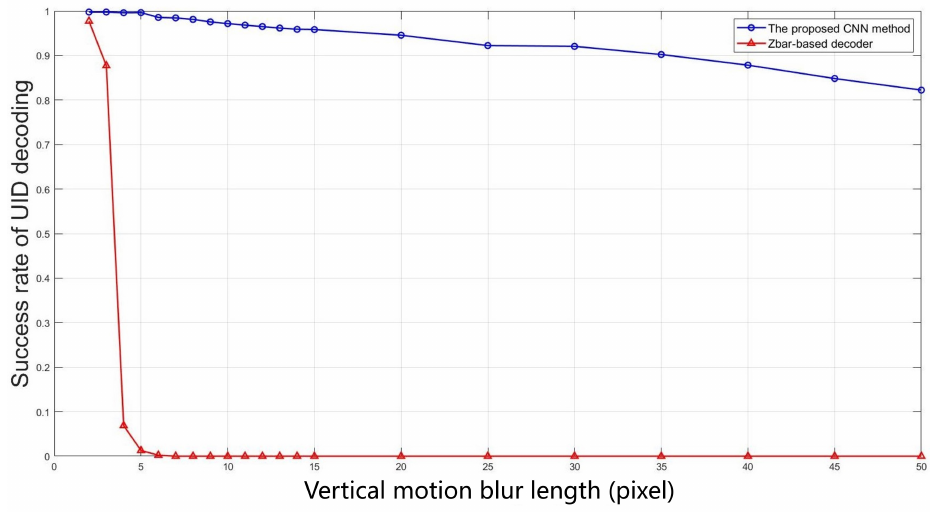
Figure 12. Success rate of UID decoding for vertical motion-blurred images using the proposed BN-CNN model versus that using the Zbar-based